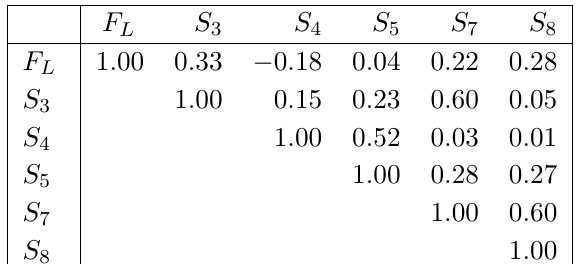
Statistical correlation matrix for the F